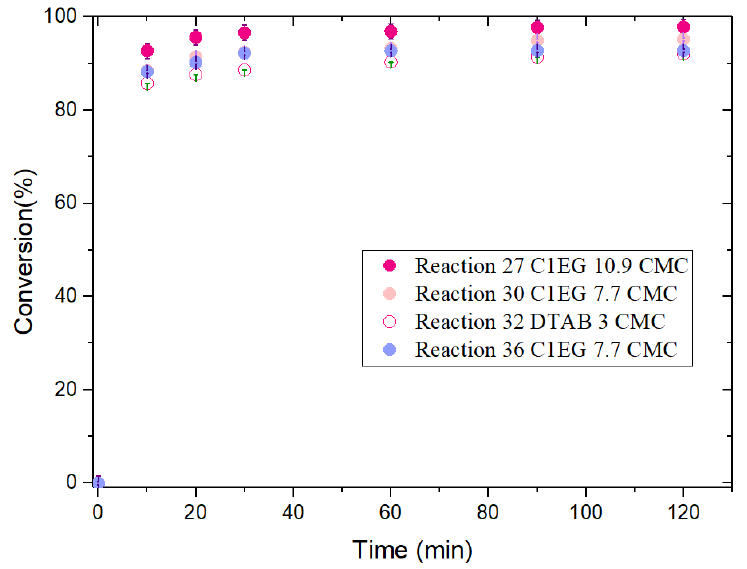
Figure 4. Evolution of monomer conversion for the EP of MMA with IL C1EG and DTAB as emulsion stabilizers at 70 °C.